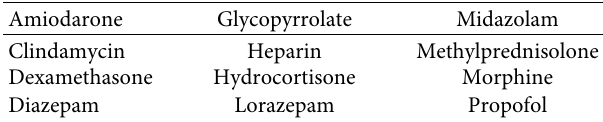
Table 2: Pharmacological agents containing benzyl alcohol often used in